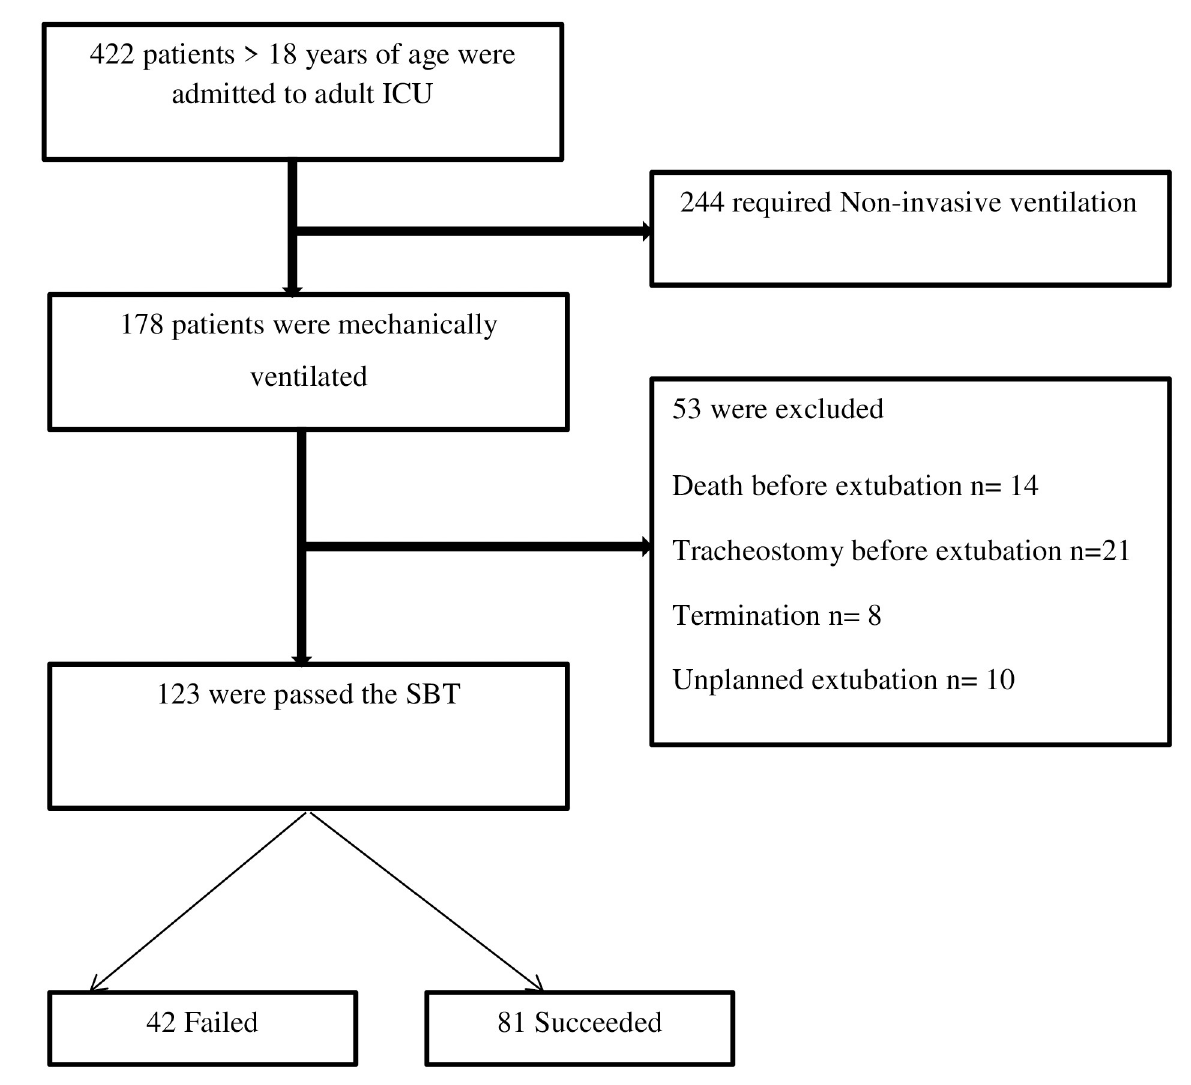
Fig 1. Flow chart of the study